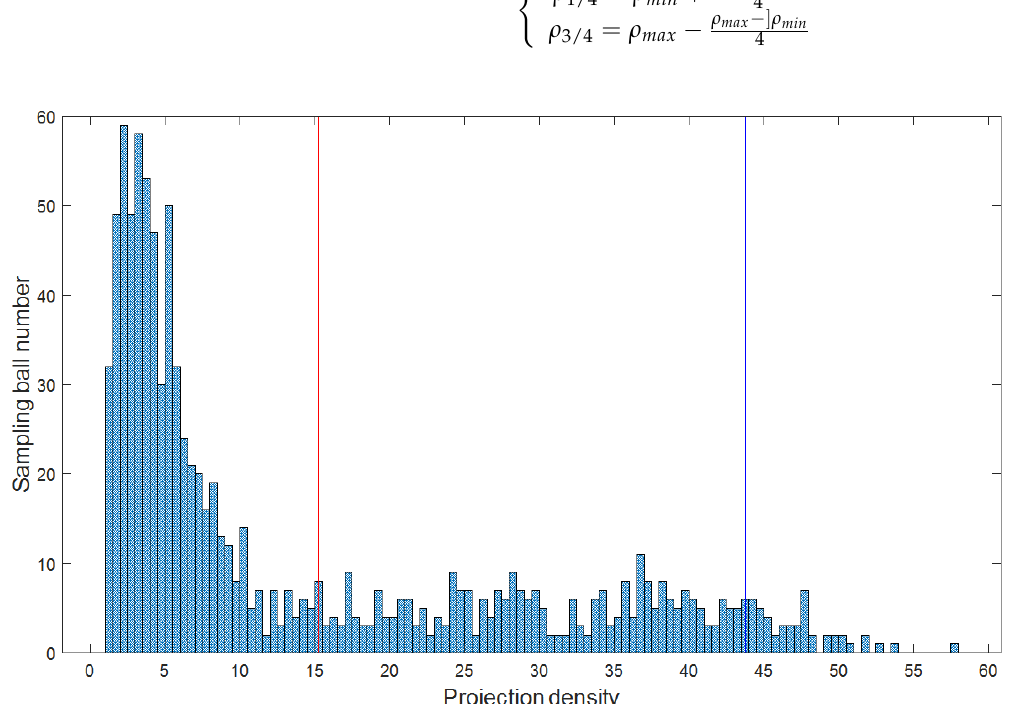
Figure 5. Histogram of the projection density distribution of randomly sampling spheres based on tree 5. The red line represents ρ 1/4 , and the blue line represents ρ 3/4